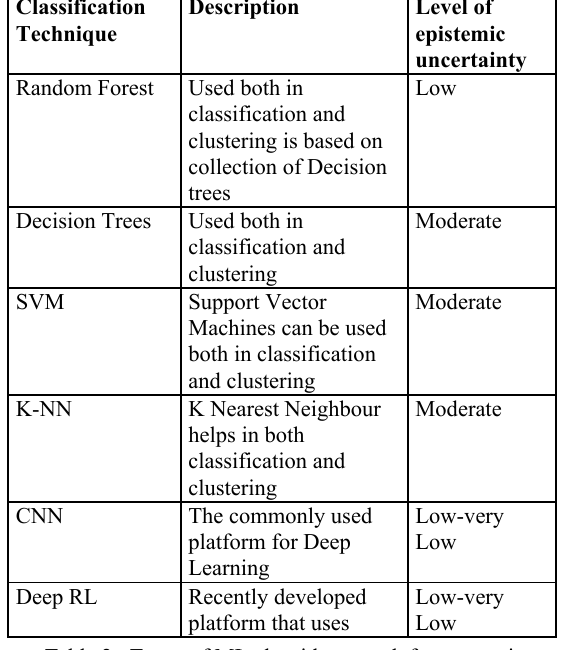
Table 2. Types of ML algorithms used for processing point cloud data and relative epistemic uncertainty